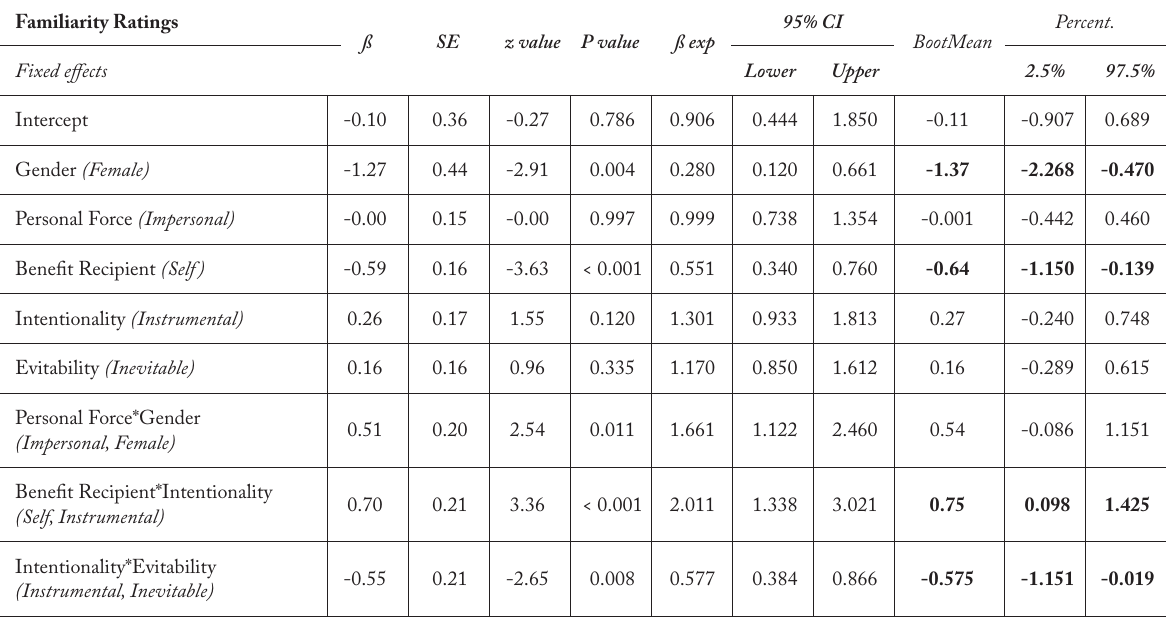
Table 5. Summary of the best linear mixed effects models on familiarity ratings for Study 2. Higher ß values indicate higher familiarity ratings.